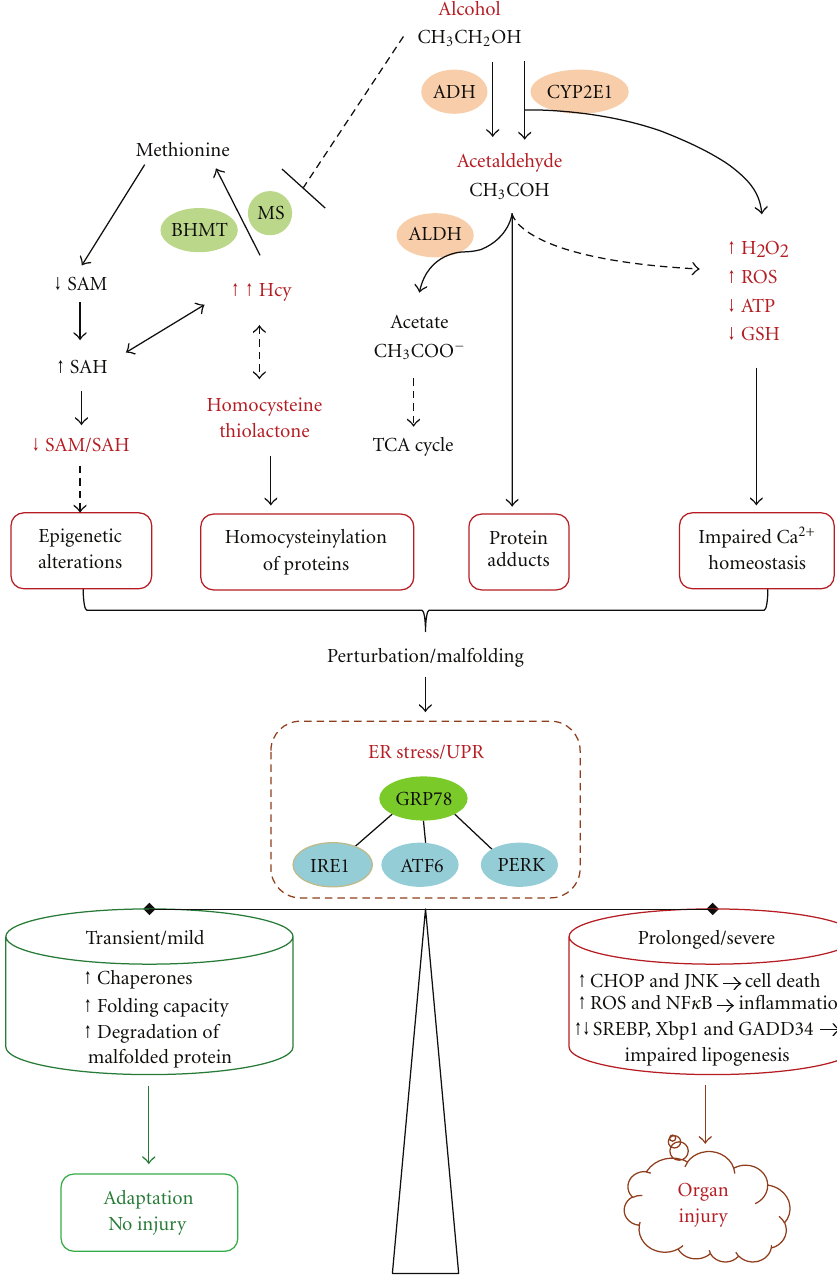
Figure 1: Mechanisms of alcohol-induced endoplasmic reticulum (ER) stress and organ injuries. ADH: alcohol dehydrogenase; ALDH: acetaldehyde dehydrogenase; CYP2E1: cytochrome P450 2E1; ROS: reactive oxidative stress; GSH: glutathione; BHMT: betaine- homocysteine methyltransferase; MS: methionine synthase; Hcy, homocysteine; SAM: S-adenosylmethionine, SAH: S-adenosylhomo- cysteine; TCA: tricarboxylic acid; UPR: unfolded protein response; GRP78: glucose-regulated protein 78; IRE1: inositol requiring enzyme; ATF6:activating transcription factor 6; PERK: protein kinase ds RNA-dependent-like ER kinase; CHOP: C/EBP-homologous protein; JNK, c-jun-N-terminal kinase; NF κ B, nuclear factor κ B; SREBP: sterol regulatory element binding protein; Xbp-1: X box binding protein 1; GADD34: growth arrest and DNA damage-inducible protein. See the context for